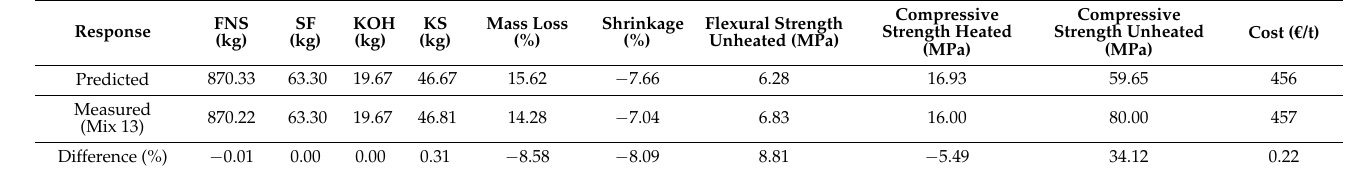
Table 7. Optimized formulations and error in